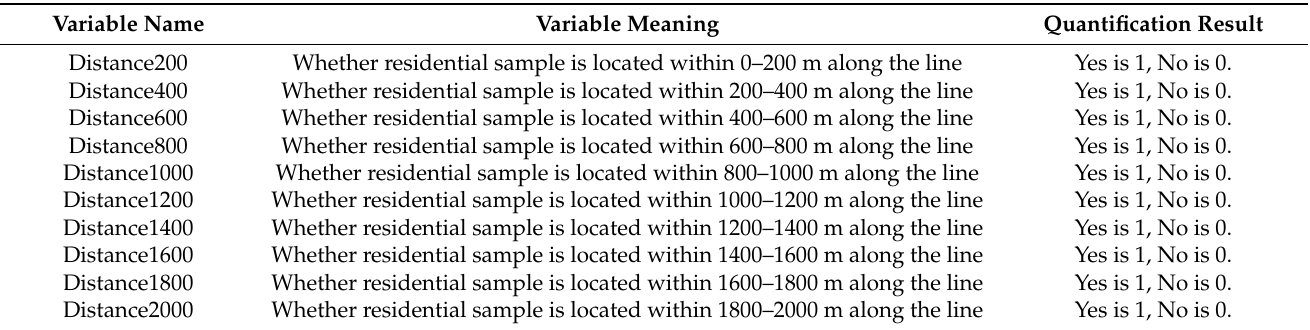
Table 3. Additional variable properties of characteristic price model.